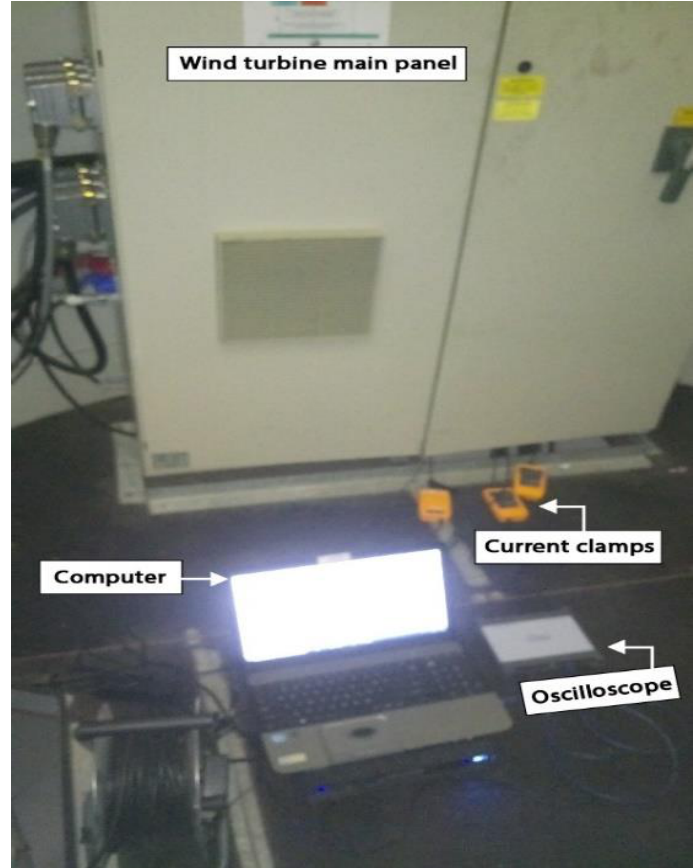
Figure 1. Generator electrical signal sampling.